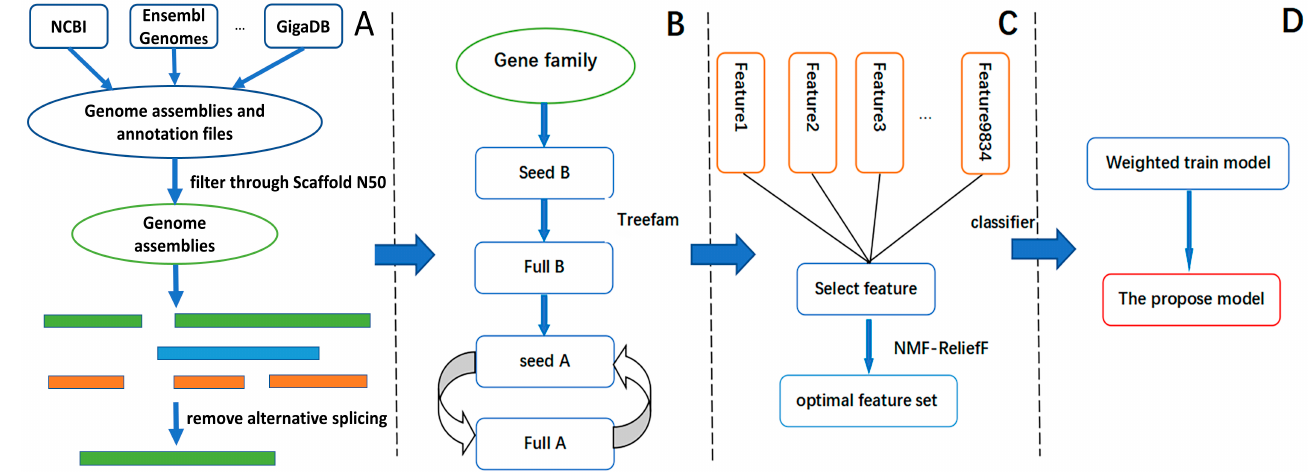
Figure 1. The framework of feature selection algorithm on gene families. Our method consists of four modules. ( A ) We collected genomes with annotation files from individual genomic databases filtered by Scaffold N50. The longest sequence length in the genomic mRNA sequence is retained and the rest of the alternative splicing is removed. ( B ) Using the TreeFam software and its database, we categorize the genome sequence of each species and construct a script to count the classification results. ( C ) Here, we design and implement a novel feature selection algorithm, NMF-ReliefF. ( D ) The final classification model is obtained by training the classifier on the reduced dimensionality feature matrix.